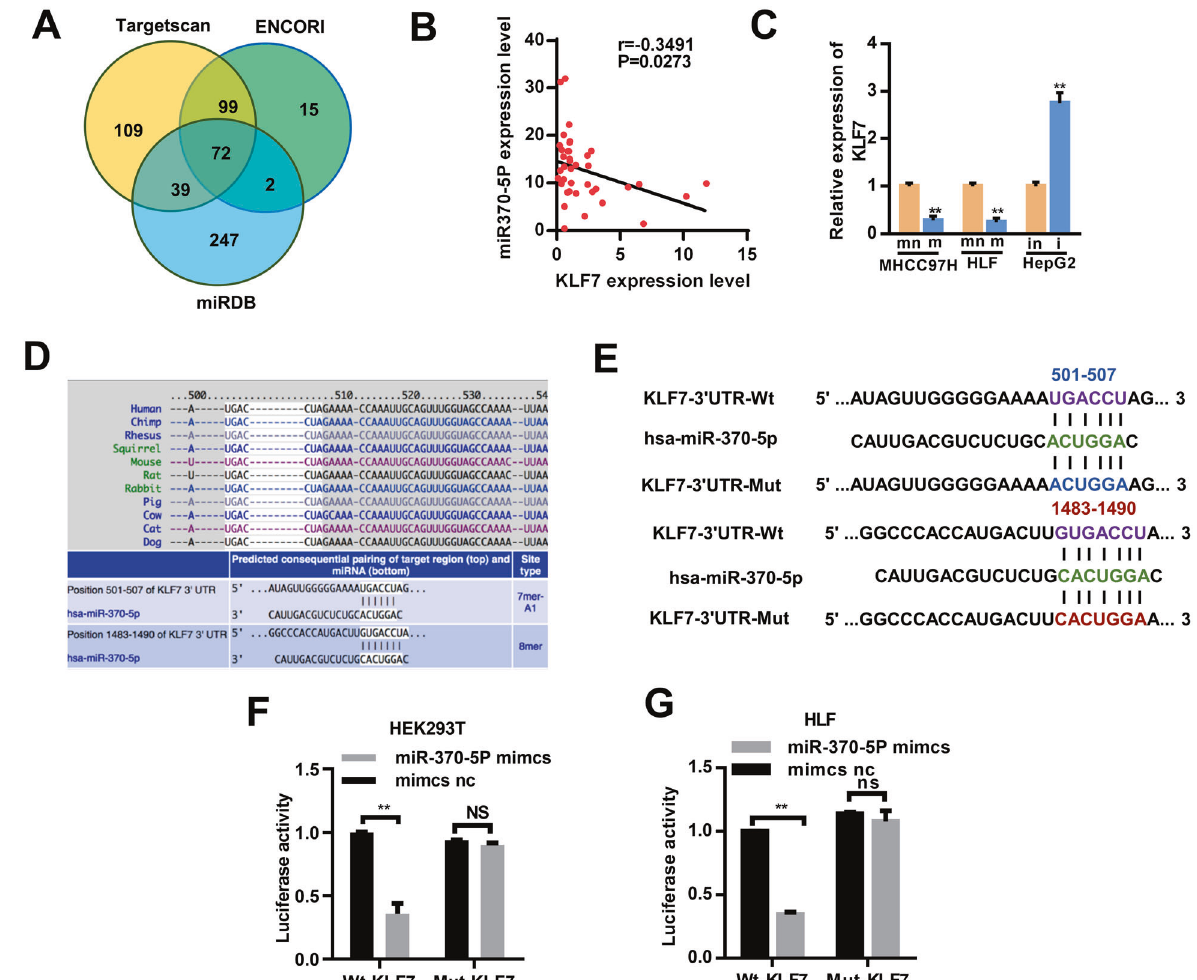
Fig. 6 KLF7 is a direct target of miR-370-5p. A Venn diagram analyses of three independent databases reveals 72 possible targets of miR370- 5P. B Pearson ’ s correlation analysis showed that miR-370-5P was inversely correlated with KLF7 mRNA levels. C Overexpression and downregulation of miR-370-5P in MHCC97H,HLF and HepG2 cells changes the KLF7 mRNA level as measured by qRT-PCR. D Bioinformatics predicted binding sites of miR-370-5P within KLF7 were shown. E A schematic drawing showing the putative binding sites. The mutant version of KLF7 is presented. F , G Relative luciferase activity determined 48 h after transfecting HEK293T cells ( D ) and HLF cells ( E ) with miR- 370-5P mimic/NC or KLF7 WT/Mut. Data are presented as means ± SD, n = 3. ** p < 0.05; ** p < 0.01. WT wild-type, Mut mutant-type, m